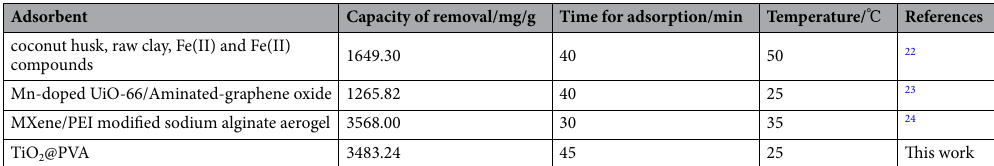
Table 2. Comparison of the Congo red removal with different adsorbents with the TiO2@PVA nanocomposite.